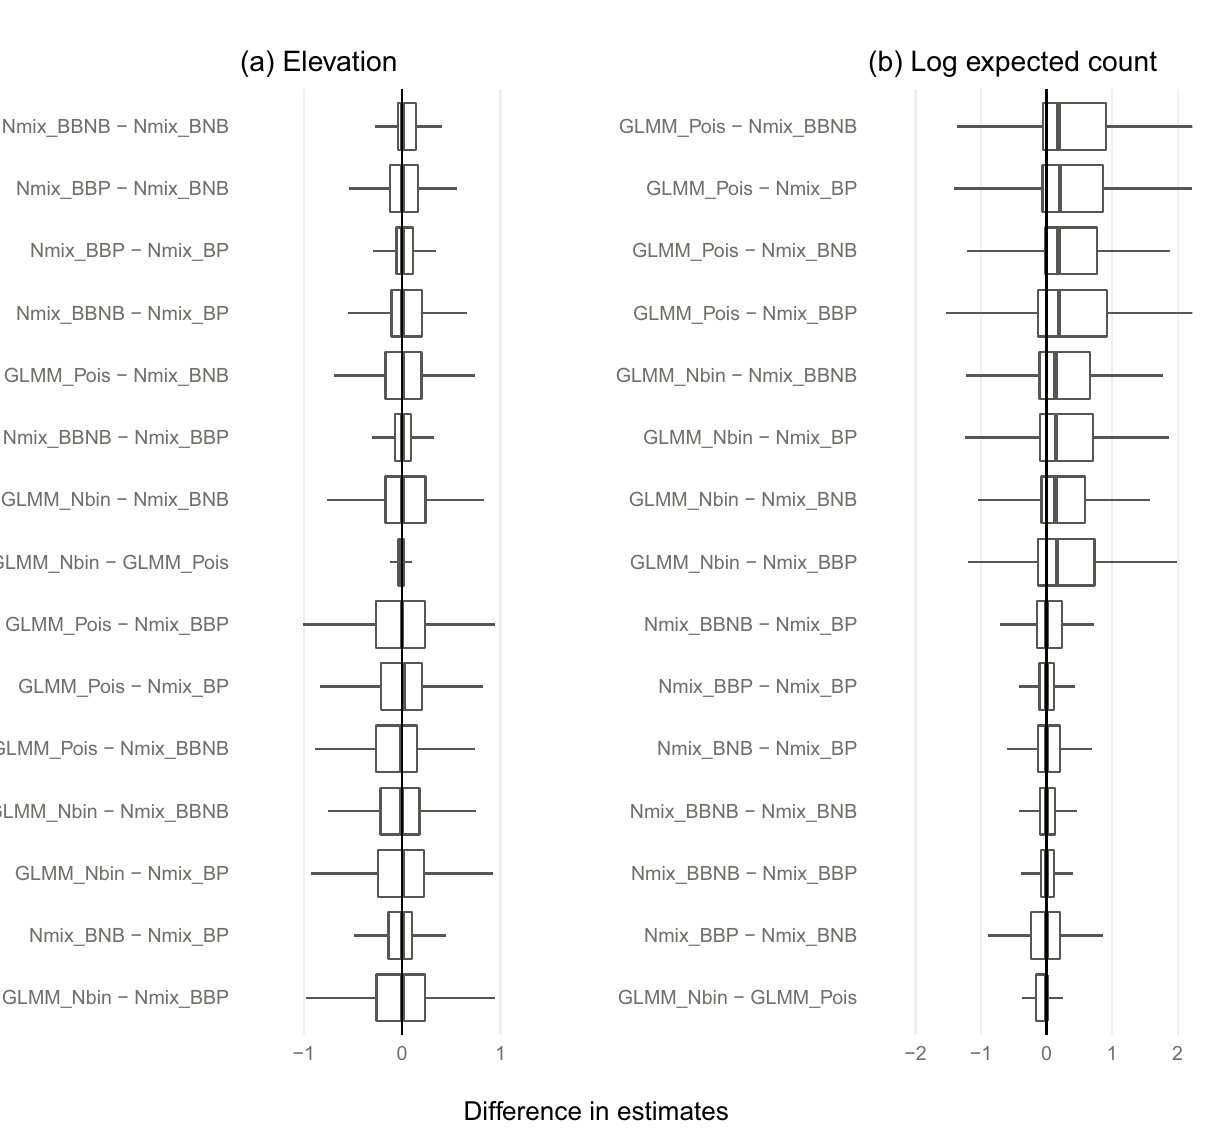
Figure 4. Distributions of the absolute differences between models in ( a ) log-scale effect of elevation and ( b ) log expected count. Model pairs are ordered by median difference. Outliers are excluded for legibility. Log expected count is the log-scale intercept plus 0.5 times the random effects variance for the GLMMs and simply the log-scale expected count intercept for N-mixture models. The latter is defined in our parameterization as a combination of abundance and detection